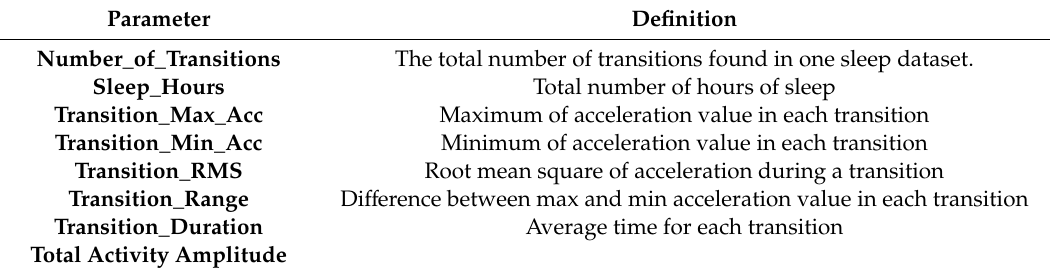
Figure 5. Maximum and minimum accelerations produced in a transition. Table 1. Parameters and their definitions.